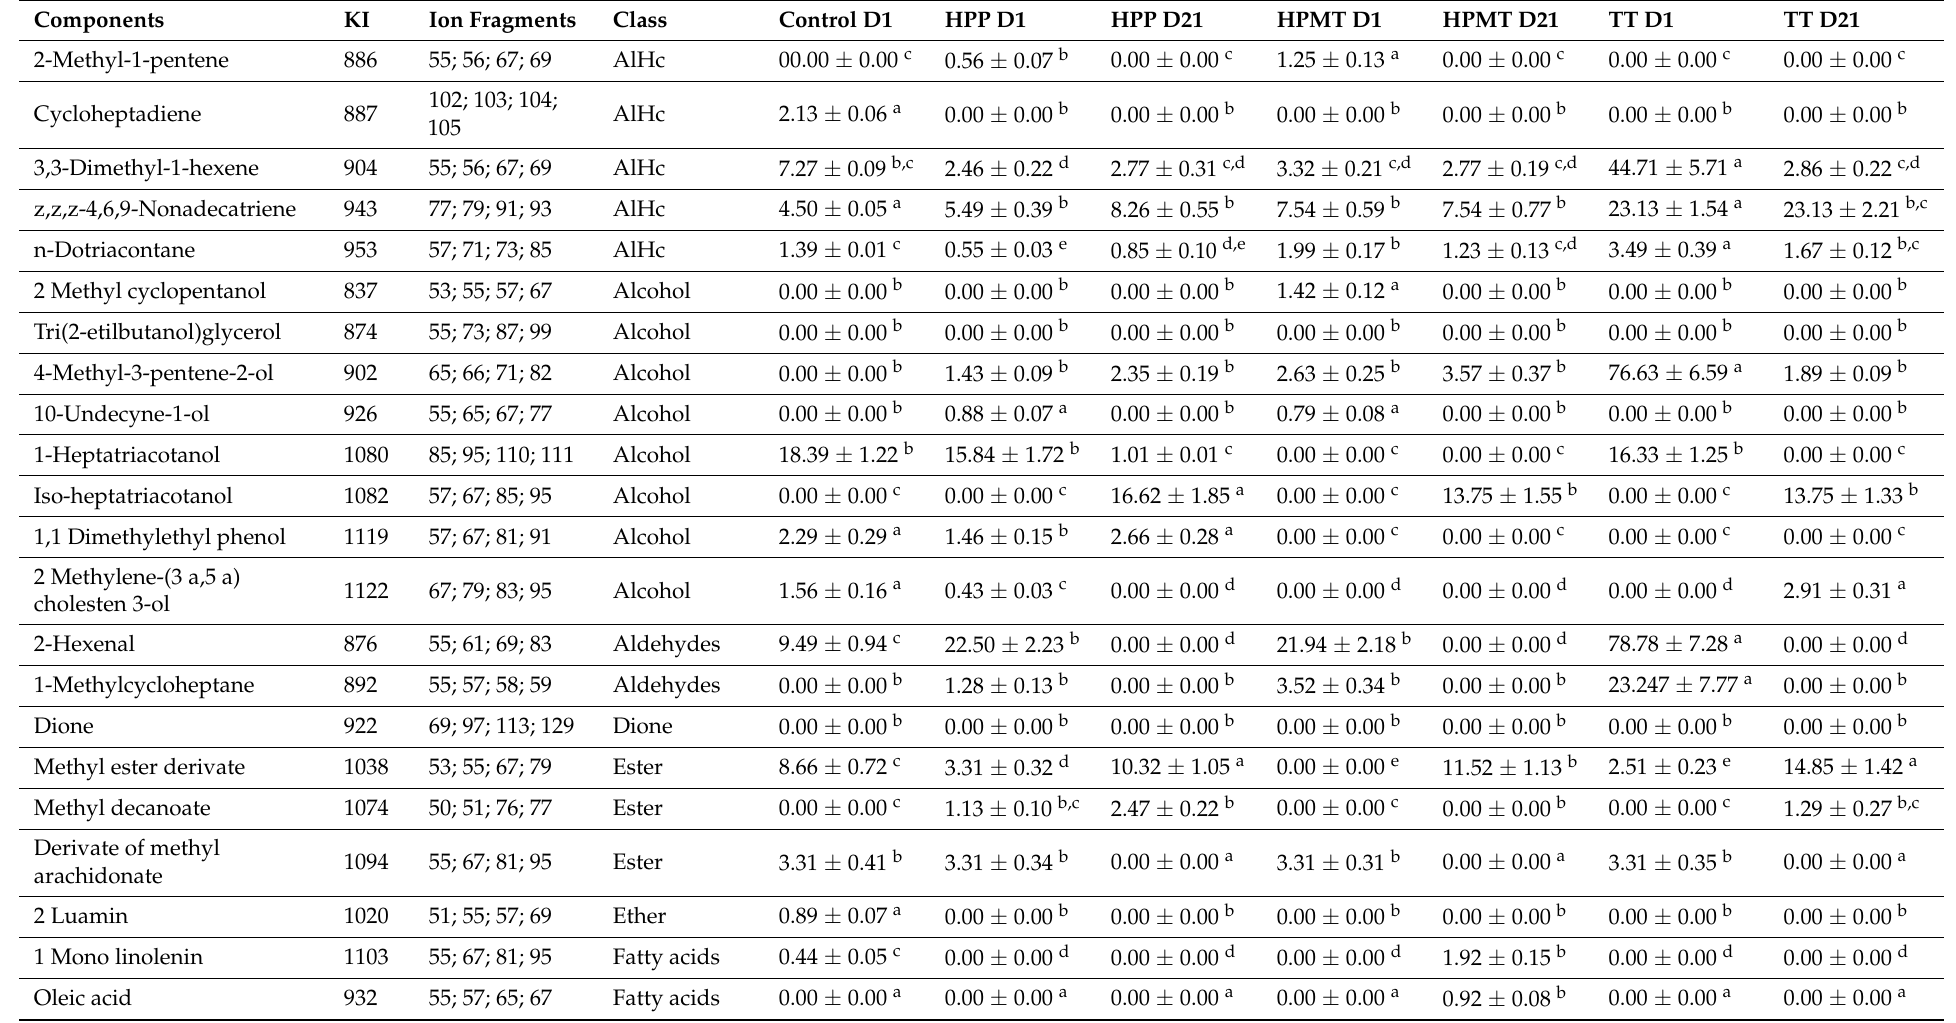
Table 3. The GC/MS SPME volatiles concentration ( µ L/kg octanol) in control sample on the first day of storage and TT, HPP and HPMT samples in the first and 21st day of storage at 4 ◦ C.